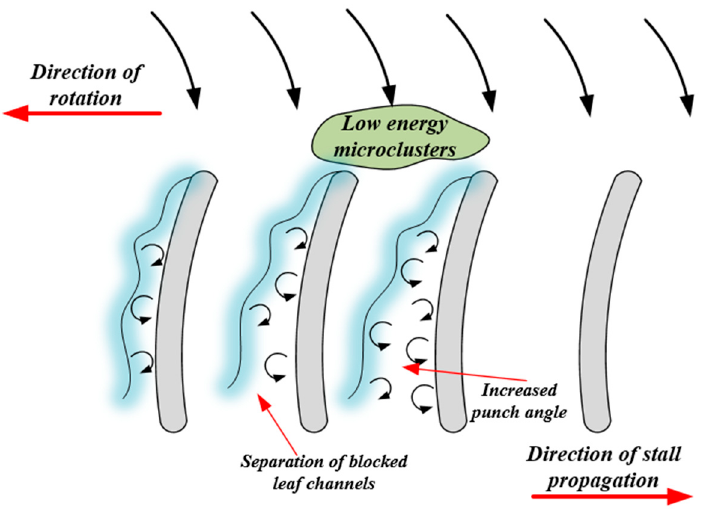
Figure 22. The formation of flow instability.